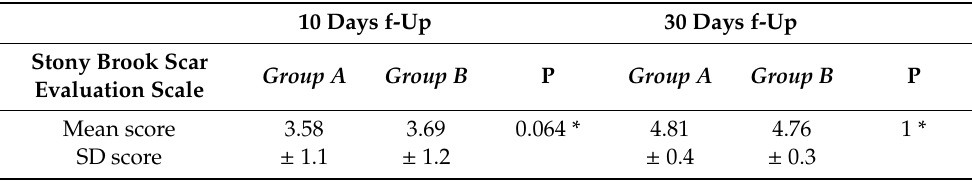
Table 3. Circumcision cosmetic healing evaluated by the Stony Brook Scar Evaluation